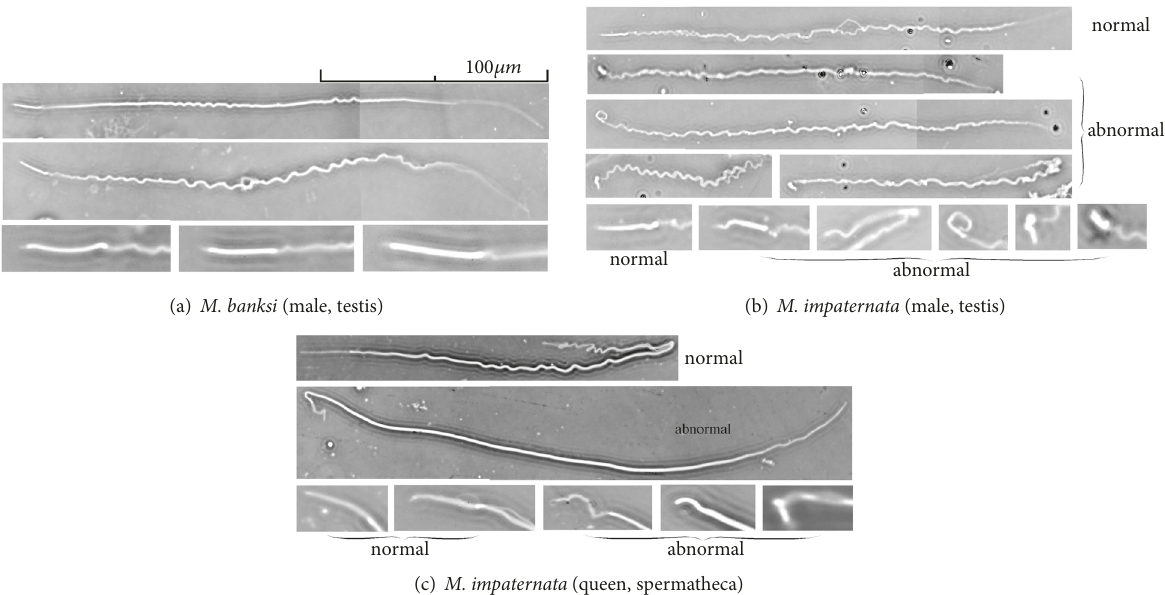
Figure 3: Morphological comparison of sperm cells from a Myrmecia banksi testis (a), an M. impaternata testis (b), and an M. impaternata queen spermatheca (c)